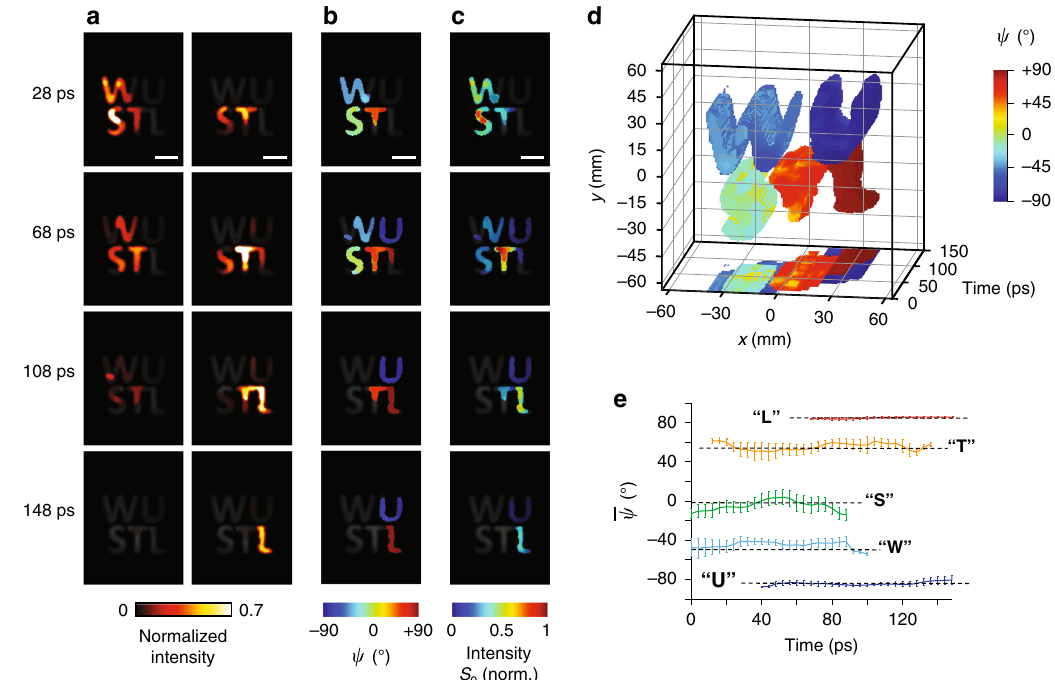
Fig. 2 Plano-polarimetric ultrafast ( x, y, z, t, ψ ) imaging using SP-CUP. a Representative frames of the reconstructed ultrafast dynamics at 250 Gfps from Views 1, 3, and 4 with the 0 o polarizers (left column) and Views 2, 5, and 6 with the 45 o polarizers (right column). The full sequence is in Supplementary Movie 1. These frames are overlaid on top of the time-unsheared image (grayscale) captured by the external CCD camera (Views 1 and 2). Note that the colormap is saturated at 0.7 in order to better display weak intensities. b , c Representative frames of the reconstructed AoLP ( ψ ) b and the fi rst Stokes parameter ( S 0 ) c . d Evolutions of ψ in the x - y plane. The projection on the x - t plane is plotted at the bottom. e Averaged values of ψ for the fi ve letters over time. The black dashed lines are the ground truths measured using the time-unsheared images (Views 1 and 2). Note that the fi nite lengths of these dashed lines are for illustration only and do not indicate durations of events. Error bars in e , standard deviations. Scale bars in a – c , 30